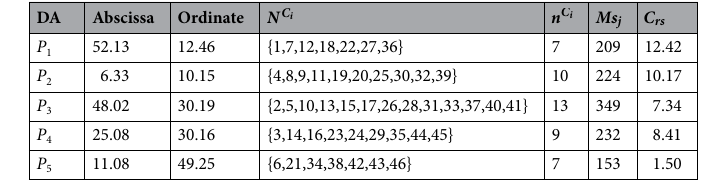
Table 4. Division of configuration transfer points based on HQDRO.